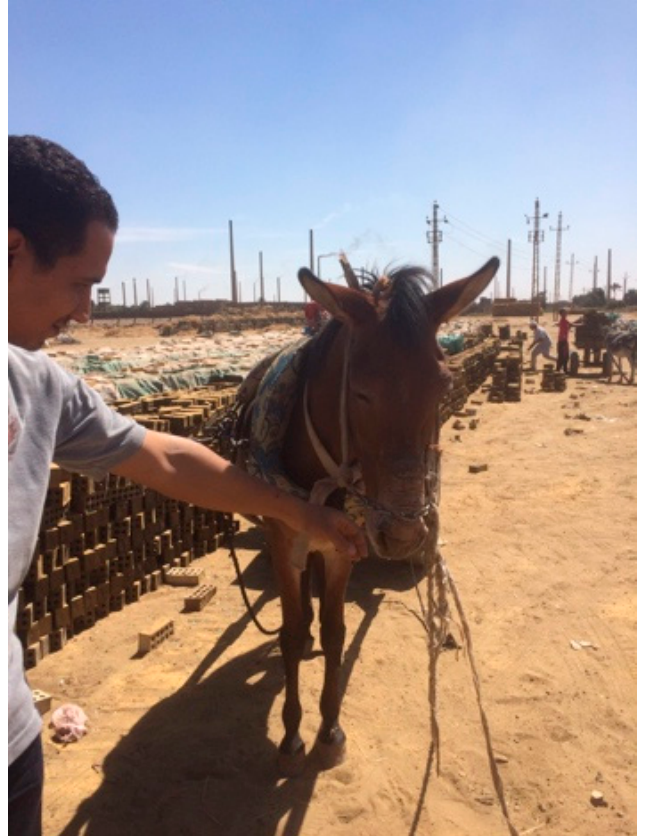
Figure 5. Approach tests in six countries have shown that mules are more accepting of familiar versus unfamiliar people. This makes attempting routine veterinary or husbandry procedures more challenging when treatment is being provided by an unfamiliar person